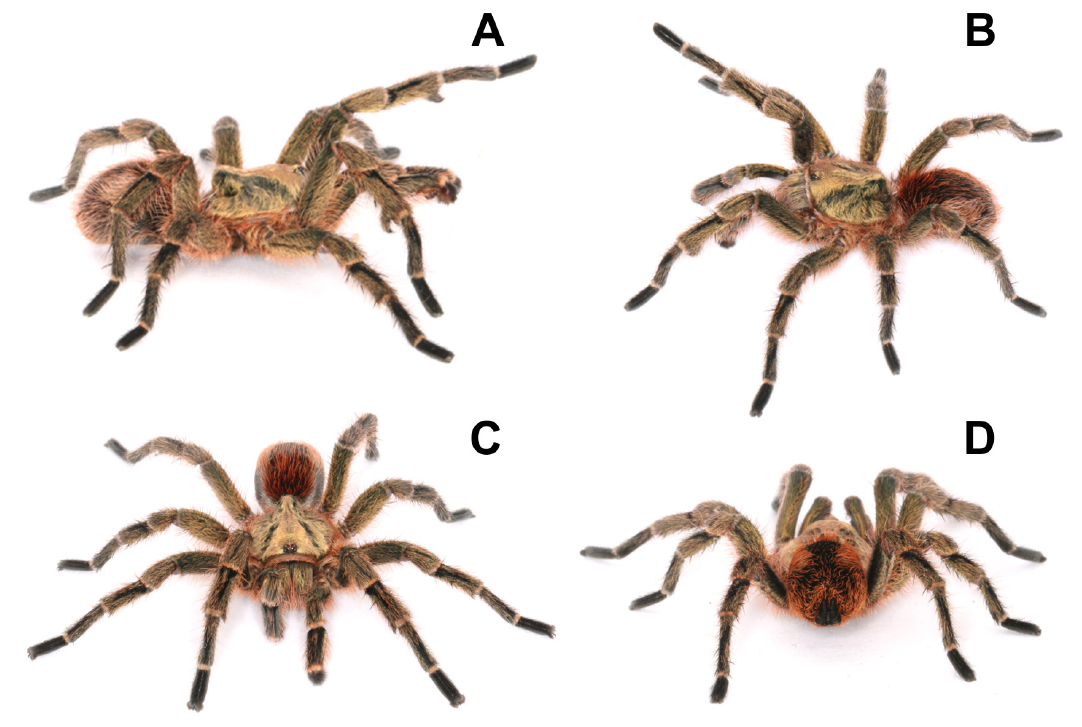
Fig. 1. Bistriopelma peyoi sp. nov., holotype, ♂ (MUBI 73). A – D . Habitus. Photos: Juan C.